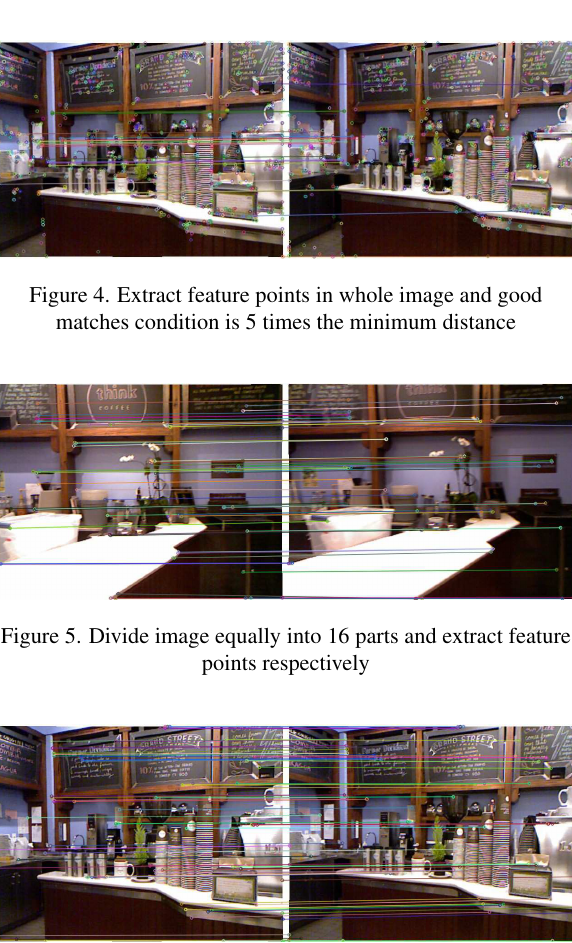
Figure 6. Divide image equally into 16 parts and extract feature points respectively